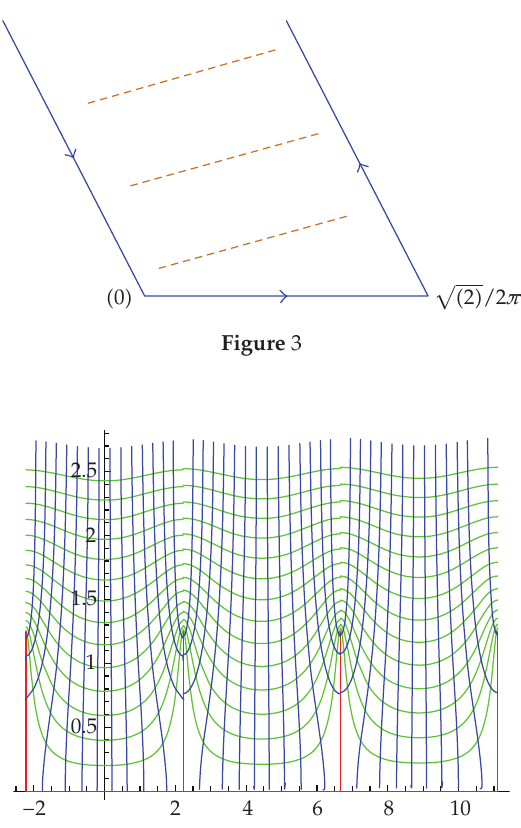
Figure 4: The hairy half-plane, f (cid:5) z (cid:6) (cid:4)